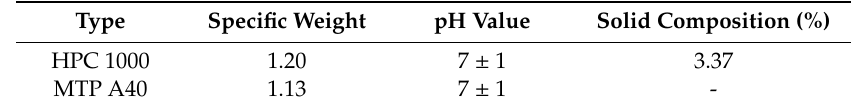
Table 2. Basic properties of superplasticizer.